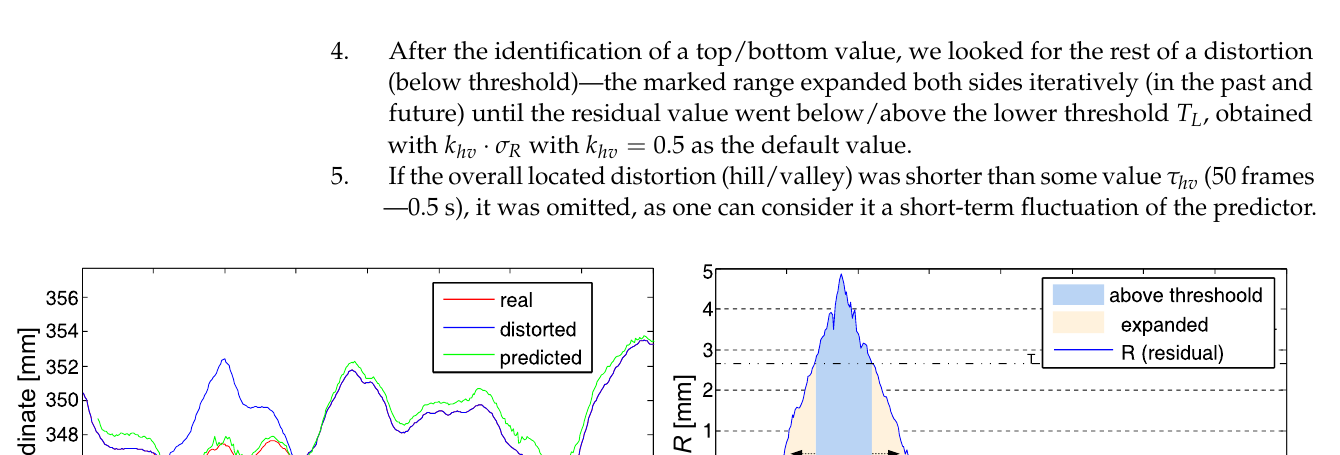
−− Figure 12. Slow detection: ( a ) original, predicted, and distorted signal, ( b ) residual with hystere- sis